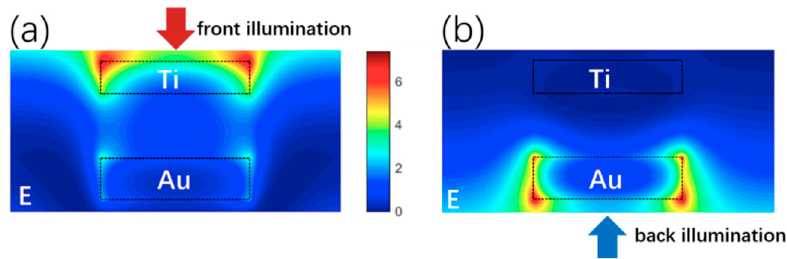
Figure 4. ( a ) Distributions of the electric field E at the resonant wavelength of 890 nm. ( b ) Distributions of the electric field E at the resonant wavelength of 910 nm.